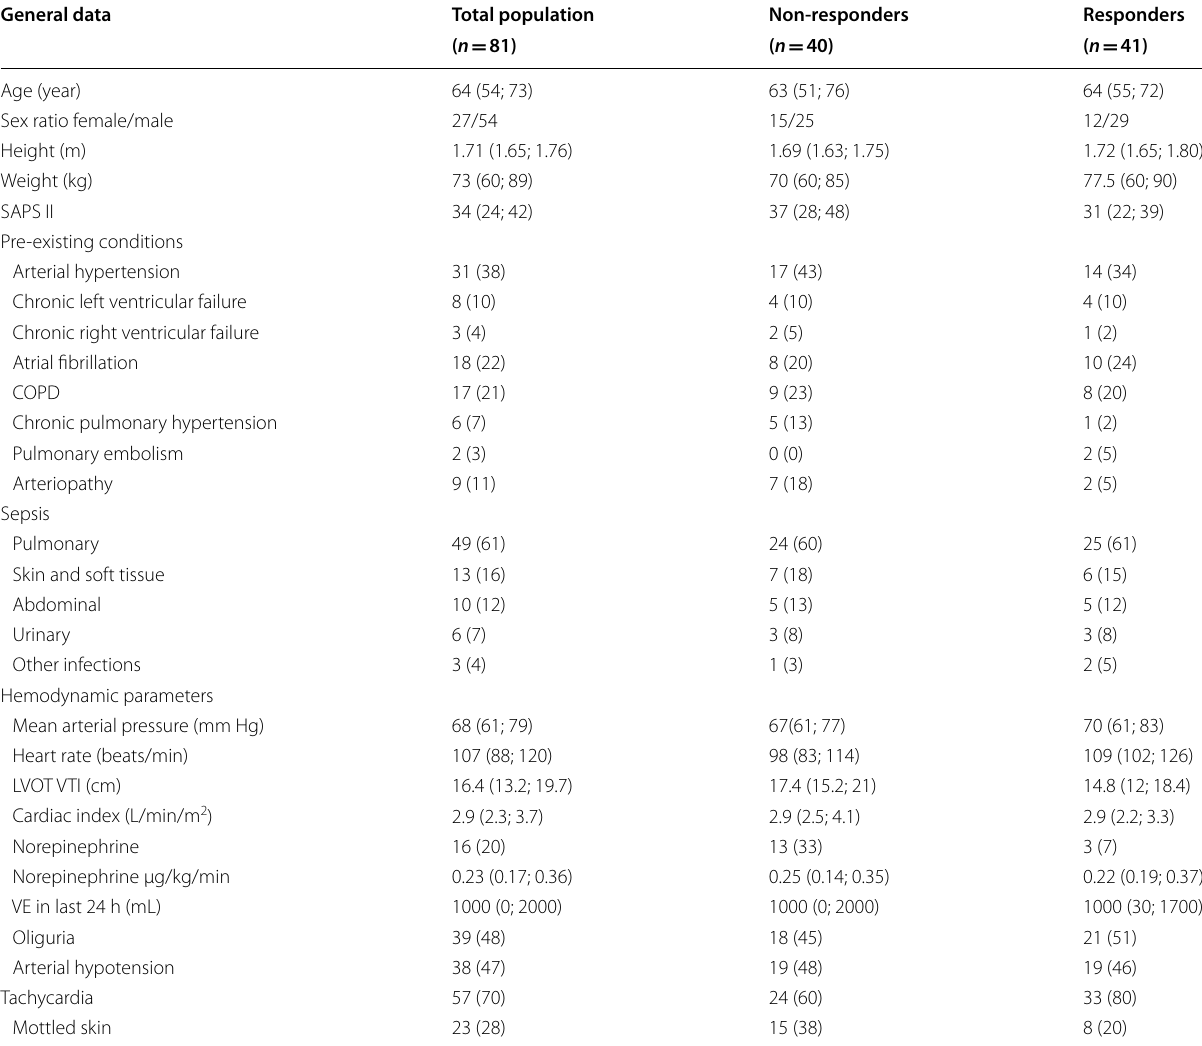
Table 1 General characteristics of the patients at inclusion